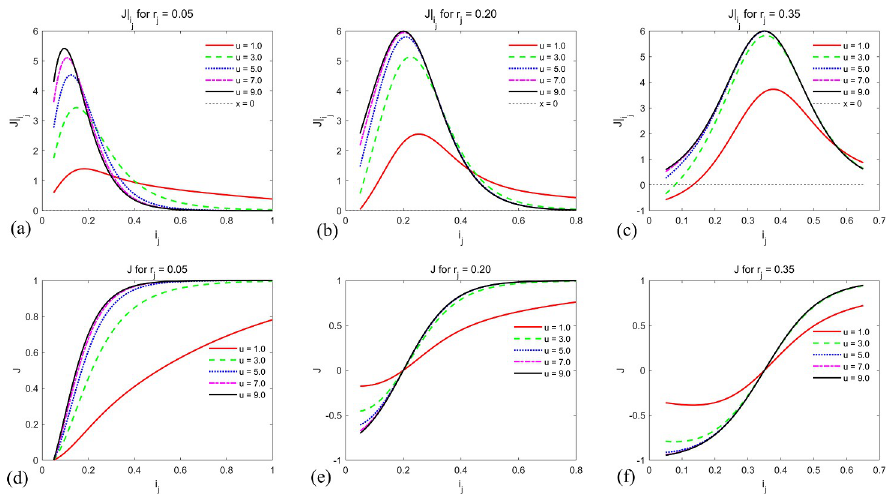
Fig 4. The change tendency of J and J j and u with r = 0.05, 0.20, 0.35, respectively. While (d)–(f) shows the change of J by different i j 0.20, 0.35, respectively.